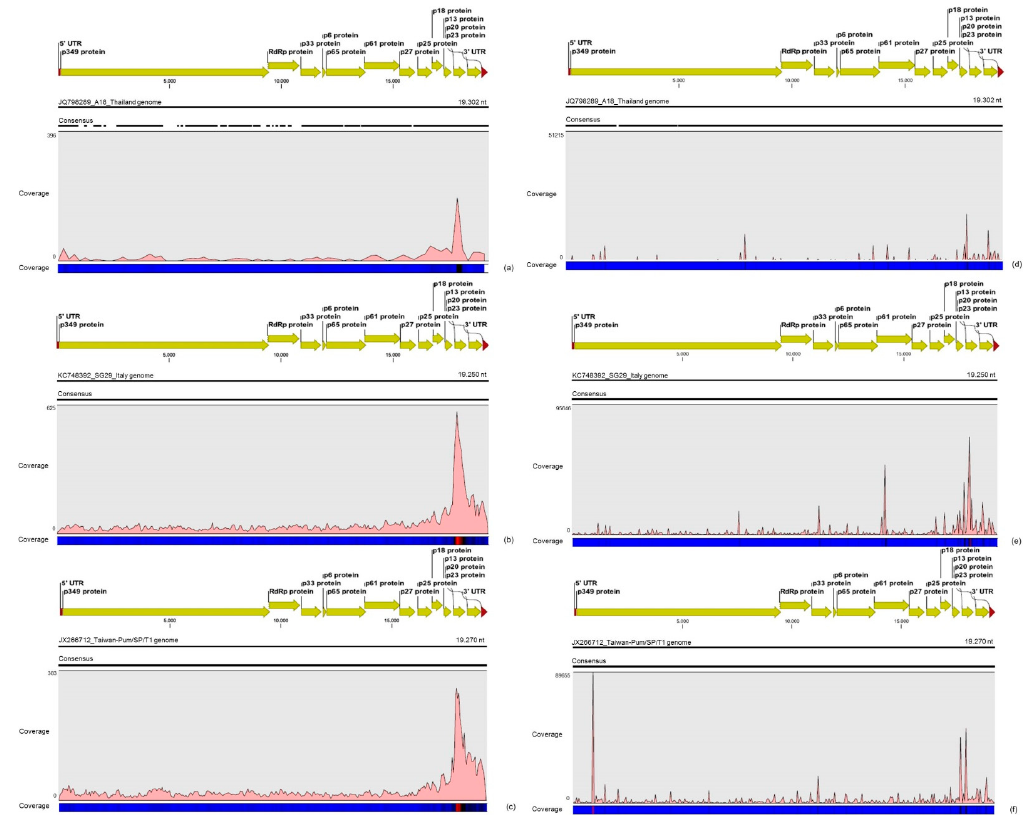
Figure 1. Profile distribution of reads from the RNA ‐ seq ( a – c ) and small RNA (sRNA) ( c – e ) libraries along the three different Citrus tristeza virus (CTV) isolates: A18 ( a , d ); SG29 ( b , e ); and Taiwan ‐ Pum/SP/1 ( c , f ). Genome organization of the CTV references is shown above the respective graphic. Color scale varies from 0 (light blue color) to 100% (red color) of coverage.